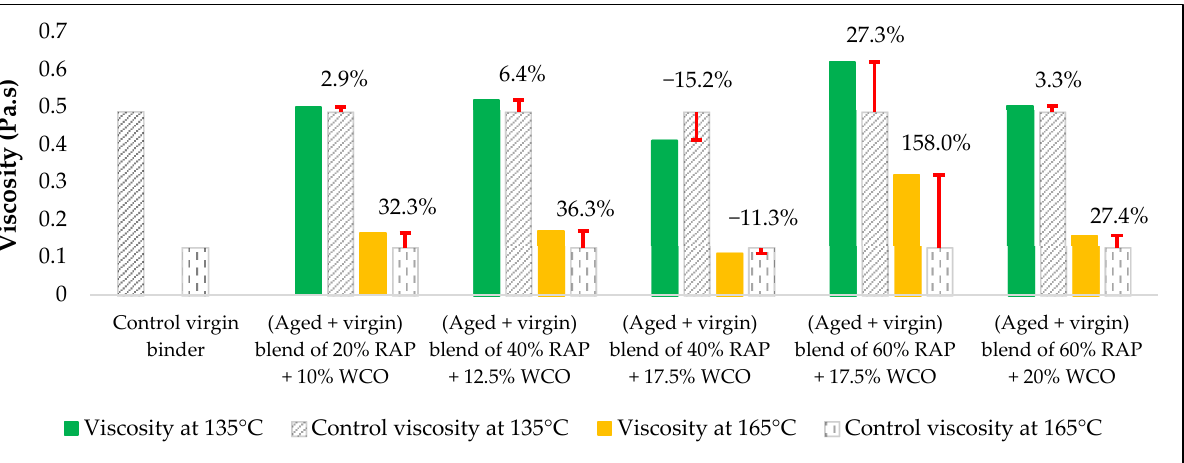
Figure 17. The change in viscosity level from adding WCO as a rejuvenator to the combined blend of binders in comparison to the control viscosity of the virgin binder.